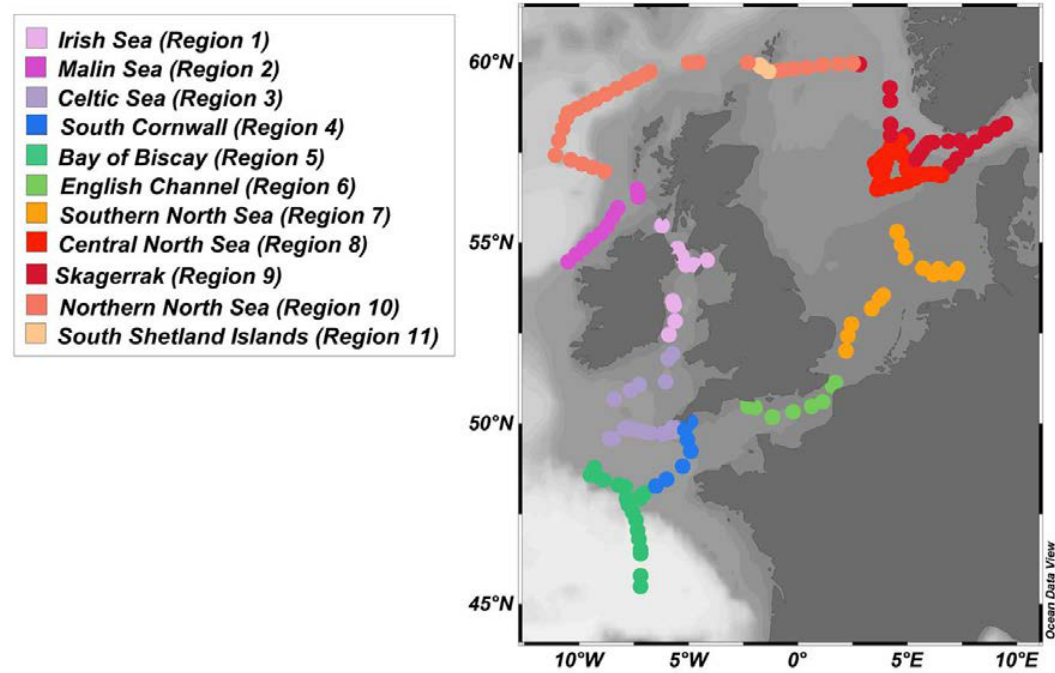
Figure 3. The 11 regions indicated using colour coding and defined using geographical and water mass (SST-SSS) characteristics. Map was produced using Ocean Data View (Schlitzer, R., Ocean Data View, odv.awi.de, 2017).